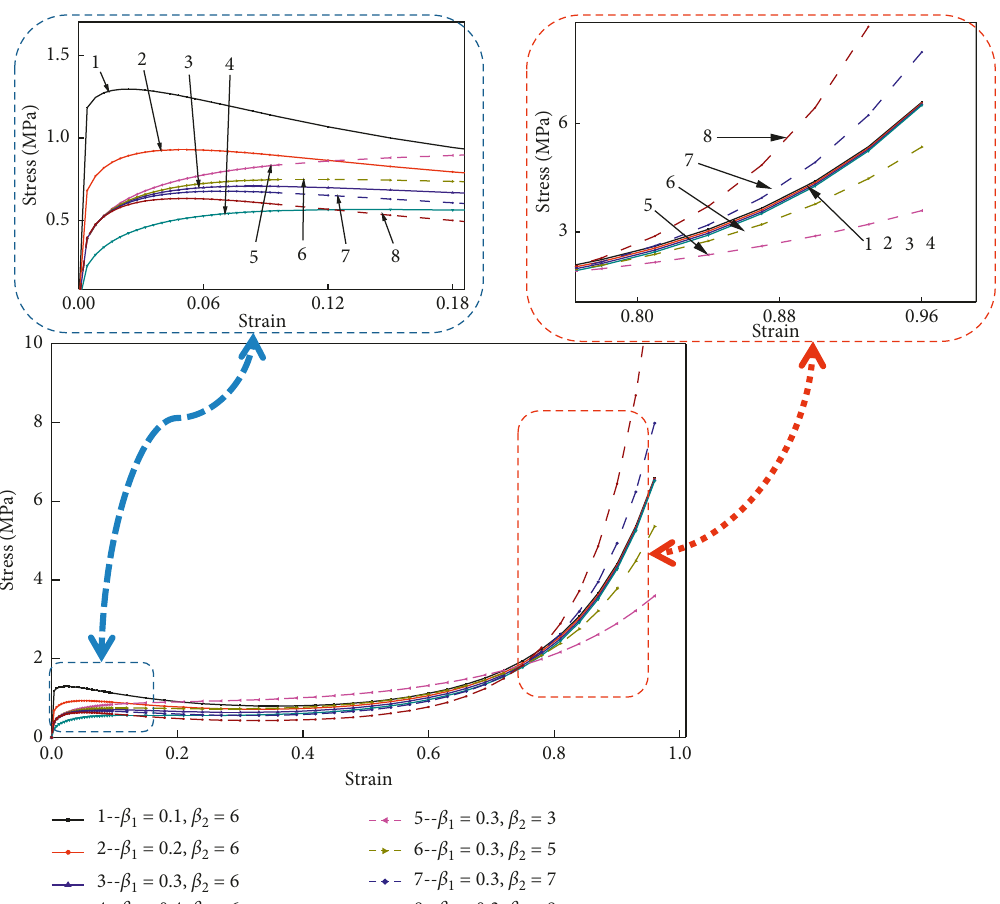
Figure 9: Constitutive model shape coefficients and its function